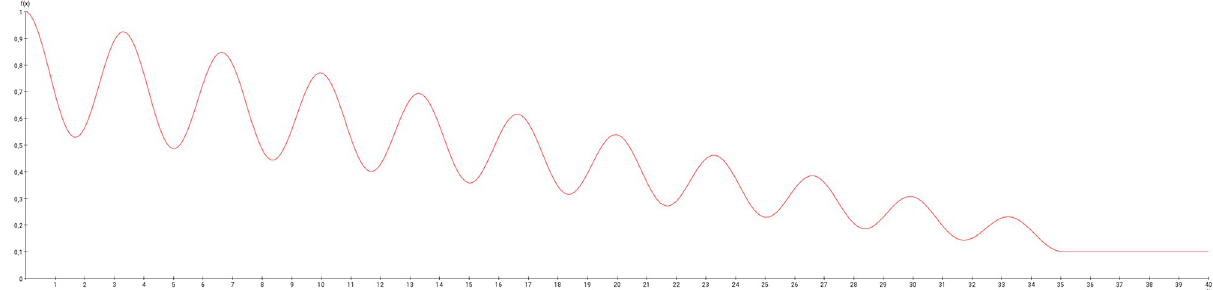
Fig 21. The weight modulation function. This weight modulation function (damped cosine function) is applied to the MM RD-system. It has the same scale of time like the MM RD simulation.